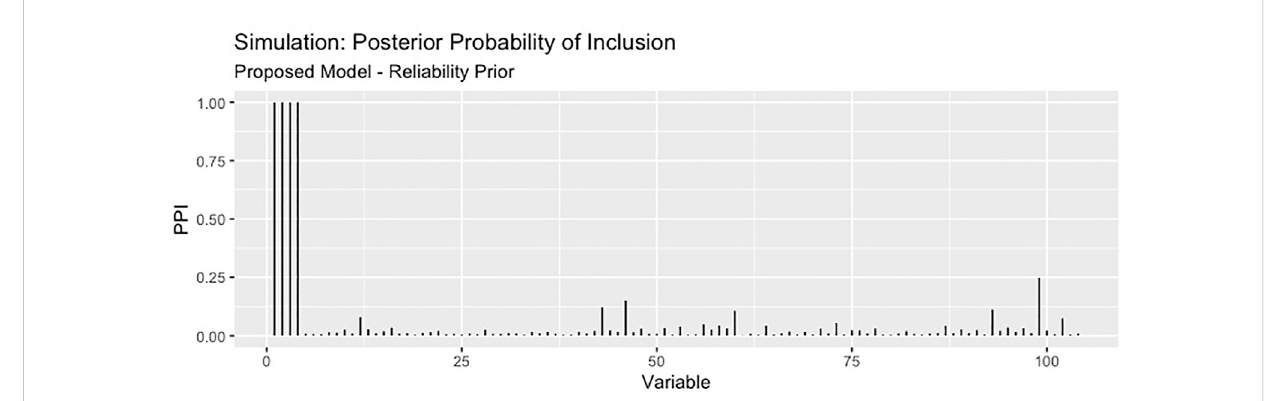
FIGURE 3 The posterior probability of inclusion for all variables from the proposed method, for one simulated data set. The fi rst four variables are the discriminatory variables, and the remaining 100 are the noise